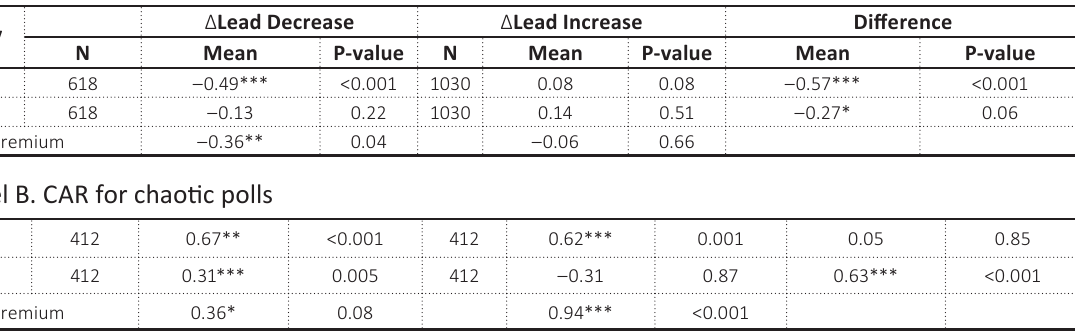
Table 5. Cumulative abnormal returns for the TVBS polls by market size Panel A. CAR for normal polls